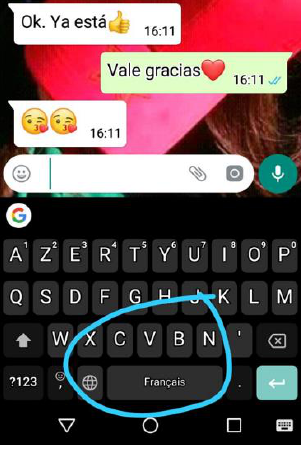
Figure 1. Digital Script.